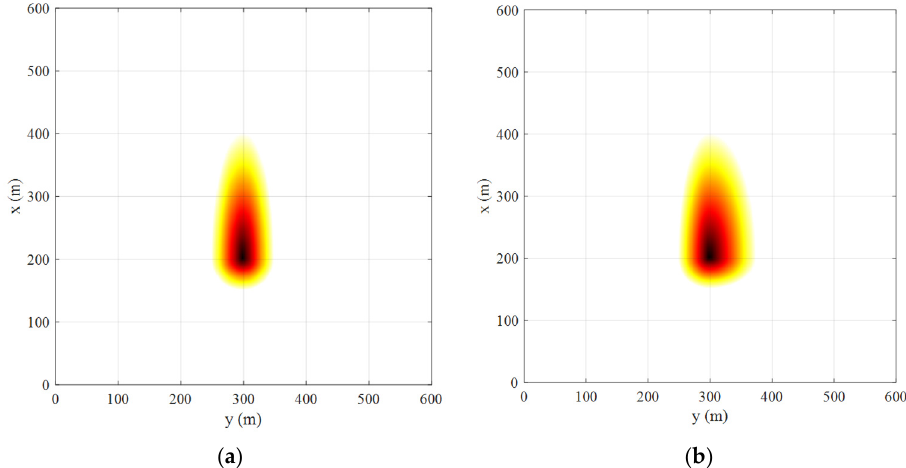
Figure 4. The representation of a dynamic obstacle with different configurations. ( a ) r 2 = 1.0 and d 2 = 50 m, ( b ) r 2 = 1.5 and d 2 = 75